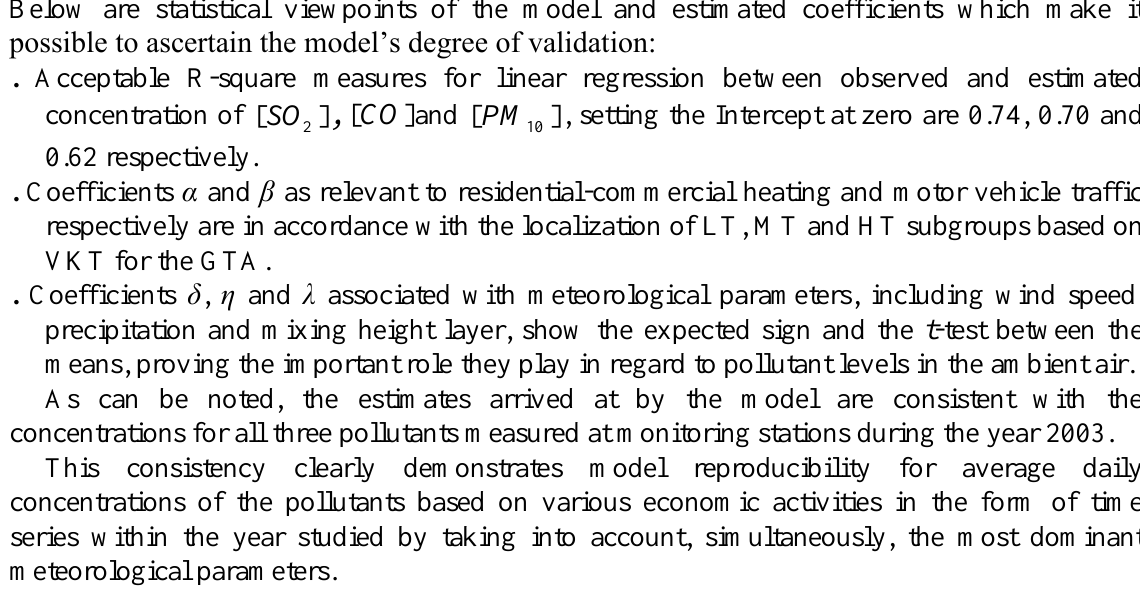
S O percent share for sub-groups in the GTA,2006 2 Source